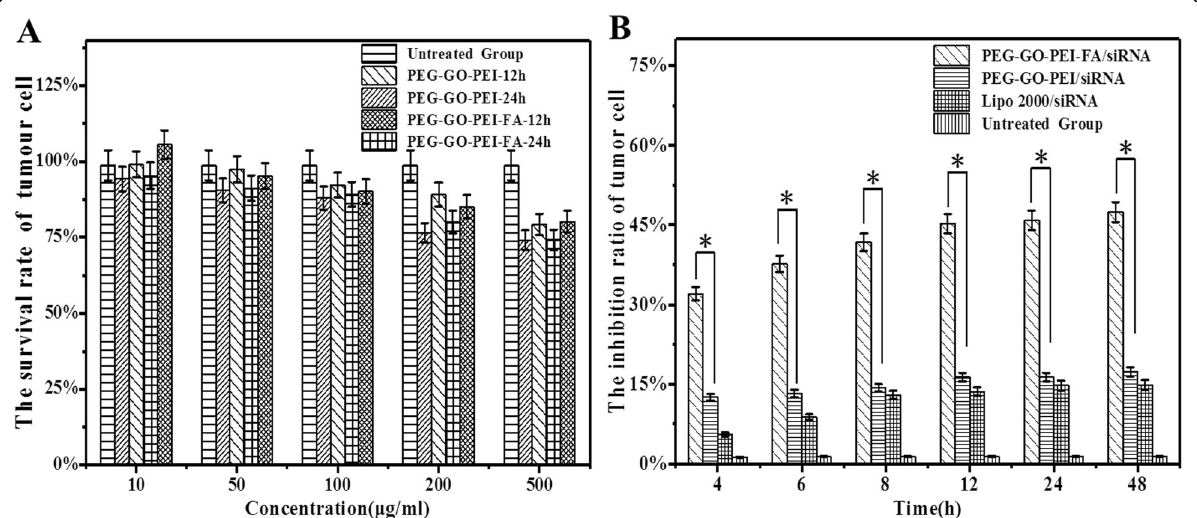
Fig. 6 In vitro cytotoxicity of PEG-GO-PEI-FA/siRNA in ovarian cancer SKOV3 cells via CCK-8 assay. a SKOV3 cells were treated with PEG-GO-PEI and PEG-GO-PEI-FA at different concentrations (10 – 500 μ g/mL) at 12 and 24 h to get the optimal dose of nanocarrier. b The cytotoxicity of PEG- GO-PEI-FA/siRNA, PEG-GO-PEI/siRNA, and Lipo2000/siRNA were measured in different time points (4 – 48 h) at 100 μ g/mL. Error bars represent ± SD; * p < 0.05 (Student ’ s t